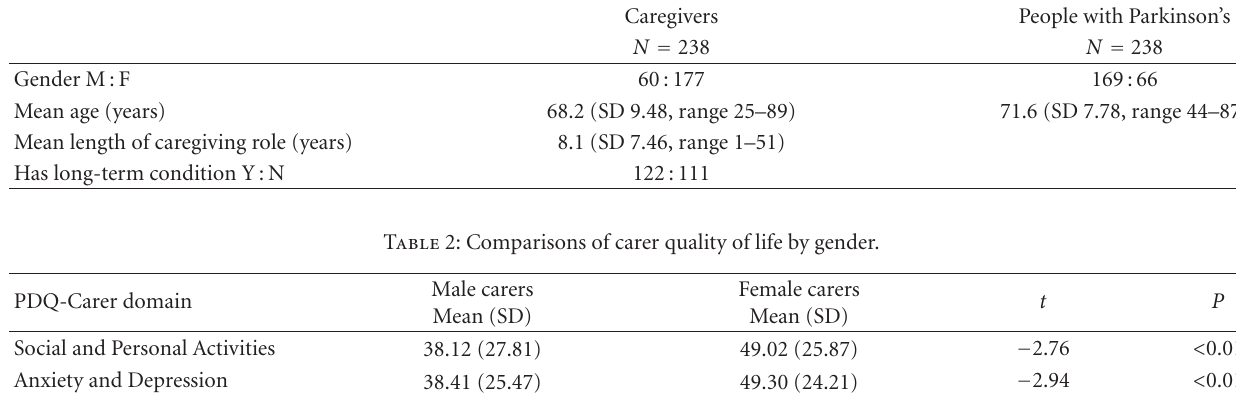
Table 1: Sample characteristics of carers and people with Parkinson’s.